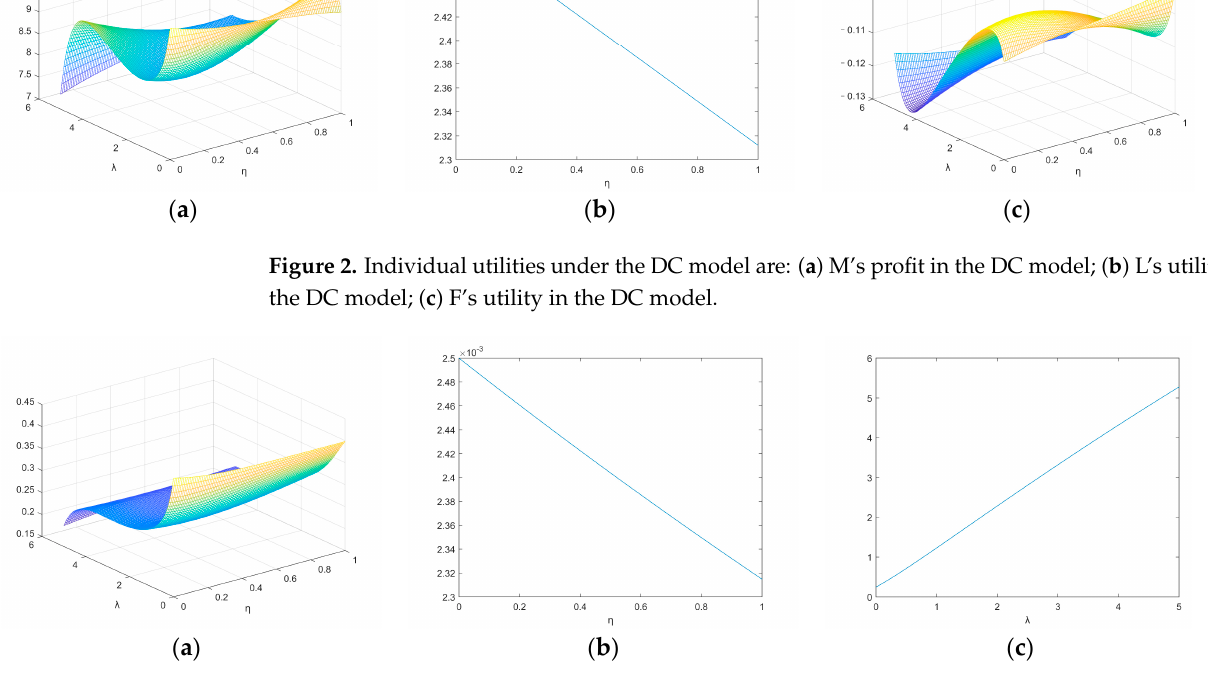
Figure 3. Individual utilities under the LF, MF, and ML models are: ( a ) M’s profit in the LF model; ( b ) L’s utility in the MF model; ( c ) F’s utility in the ML model.